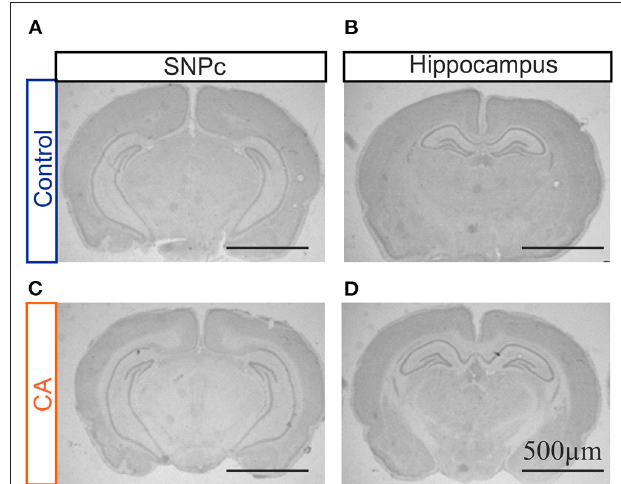
TABLE 1 | Characteristics of animals included in the study.